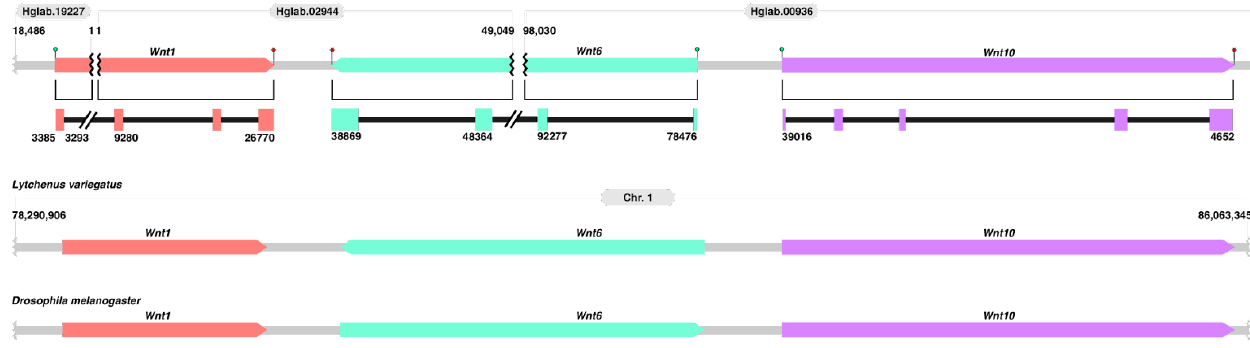
Figure 4. Wnt cluster conservation. Schematic illustrating the conservation of the Wnt1-Wnt6-Wnt10 cluster in H. glaberrima compared to L. variegatus and Drosophila melanogaster (adapted from [47]). For H. glaberrima , we show the distribution of these genes across the draft assembly by complete squares with arrow heads pointing in the direction of the gene in the scaffold. The coordinates on top of the gene structures show scaffold size. The IDs on top of each gene structure represent the scaffold ID (NCBI ID: GCA_009936505.2). Separations of each Wnt due to fragmentation are shown as black line breaks. Start and stop codons are represented by green circles and red stars, respectively. The cluster of L. variegatus was characterized using its latest genome (Lvar_3.0; NCBI ID: 3495).